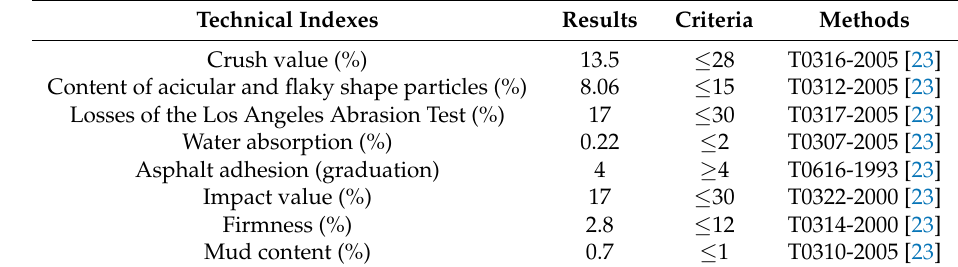
Table 3. Coarse aggregate properties.